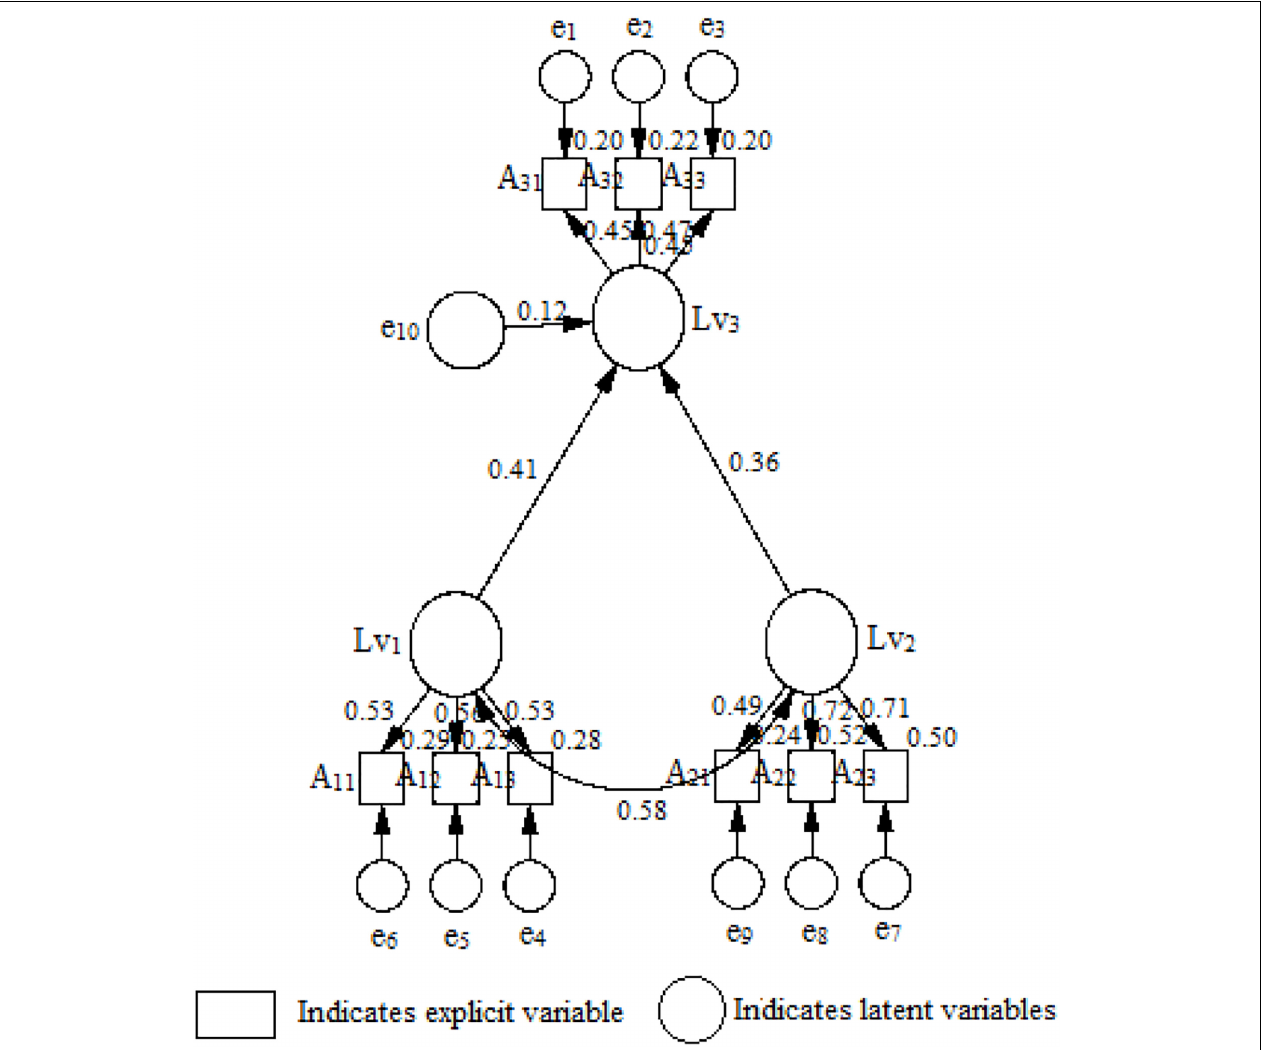
FIGURE 3 | Structural equation model of the impact of comprehensive energy development on regional economic growth.